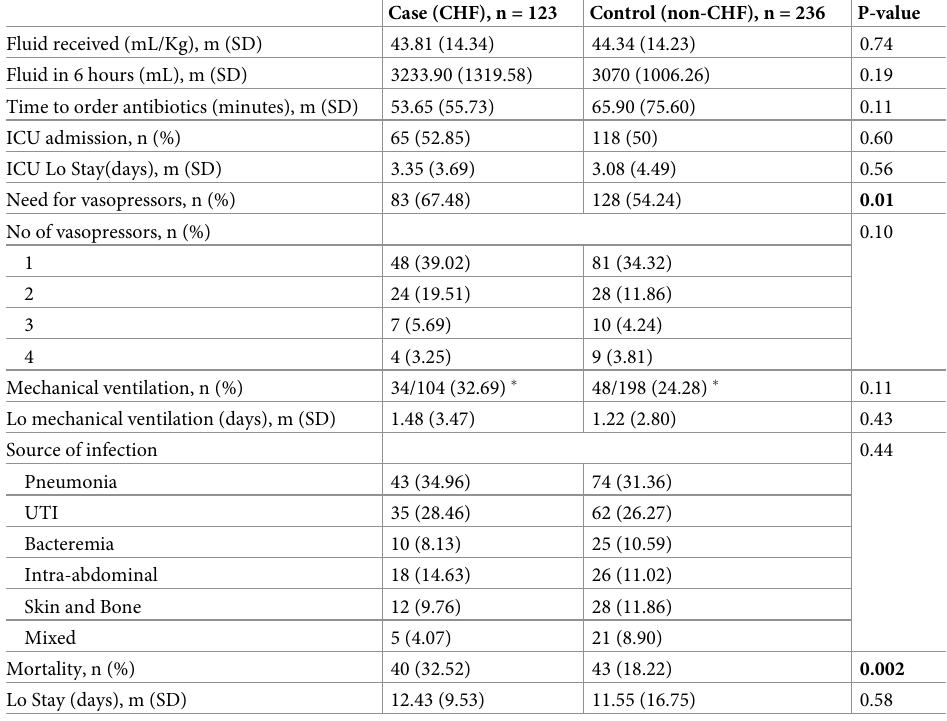
Table 2. Comparison of secondary outcomes in the primary groups that received � 30 mL/Kg fluid bolus. Case (CHF), n = 123 Control (non-CHF), n = 236 P-value Fluid received (mL/Kg), m (SD) 43.81 (14.34) 44.34 (14.23) 0.74 Fluid in 6 hours (mL), m (SD) 3233.90 (1319.58) 3070 (1006.26) 0.19 Time to order antibiotics (minutes), m (SD) 53.65 (55.73) 65.90 (75.60) 0.11 ICU admission, n (%) 65 (52.85) 118 (50) 0.60 ICU Lo Stay(days), m (SD) 3.35 (3.69) 3.08 (4.49) 0.56 Need for vasopressors, n (%) 83 (67.48) 128 (54.24) 0.01 No of vasopressors, n (%) 0.10 1 48 (39.02) 81 (34.32) 2 24 (19.51) 28 (11.86) 3 7 (5.69) 10 (4.24) 4 4 (3.25) 9 (3.81) Mechanical ventilation, n (%) 34/104 (32.69) � 48/198 (24.28) � 0.11 Lo mechanical ventilation (days), m (SD) 1.48 (3.47) 1.22 (2.80) 0.43 Source of infection 0.44 Pneumonia 43 (34.96) 74 (31.36) UTI 35 (28.46) 62 (26.27) Bacteremia 10 (8.13) 25 (10.59) Intra-abdominal 18 (14.63) 26 (11.02) Skin and Bone 12 (9.76) 28 (11.86) Mixed 5 (4.07) 21 (8.90) Mortality, n (%) 40 (32.52) 43 (18.22) 0.002 Lo Stay (days), m (SD) 12.43 (9.53) 11.55 (16.75) 0.58 M = mean; n = number; SD = Standard Deviation; ICU = Intensive Care Unit; Lo = Length of; UTI = Urinary Tract Infection. � Mechanical ventilation rate calculated after removing DNI (Do Not Intubate) patients. Significant P-values are in